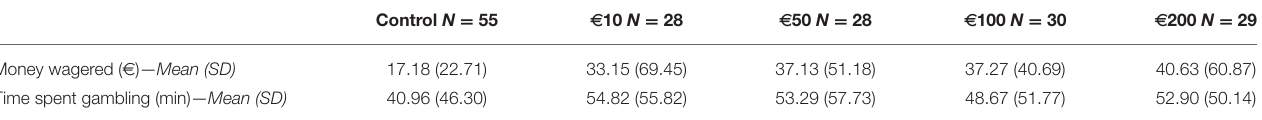
TABLE 3 | Description of the two main outcomes (averaged money wagered and time spent gambling during the gambling session), according to the experimental condition.